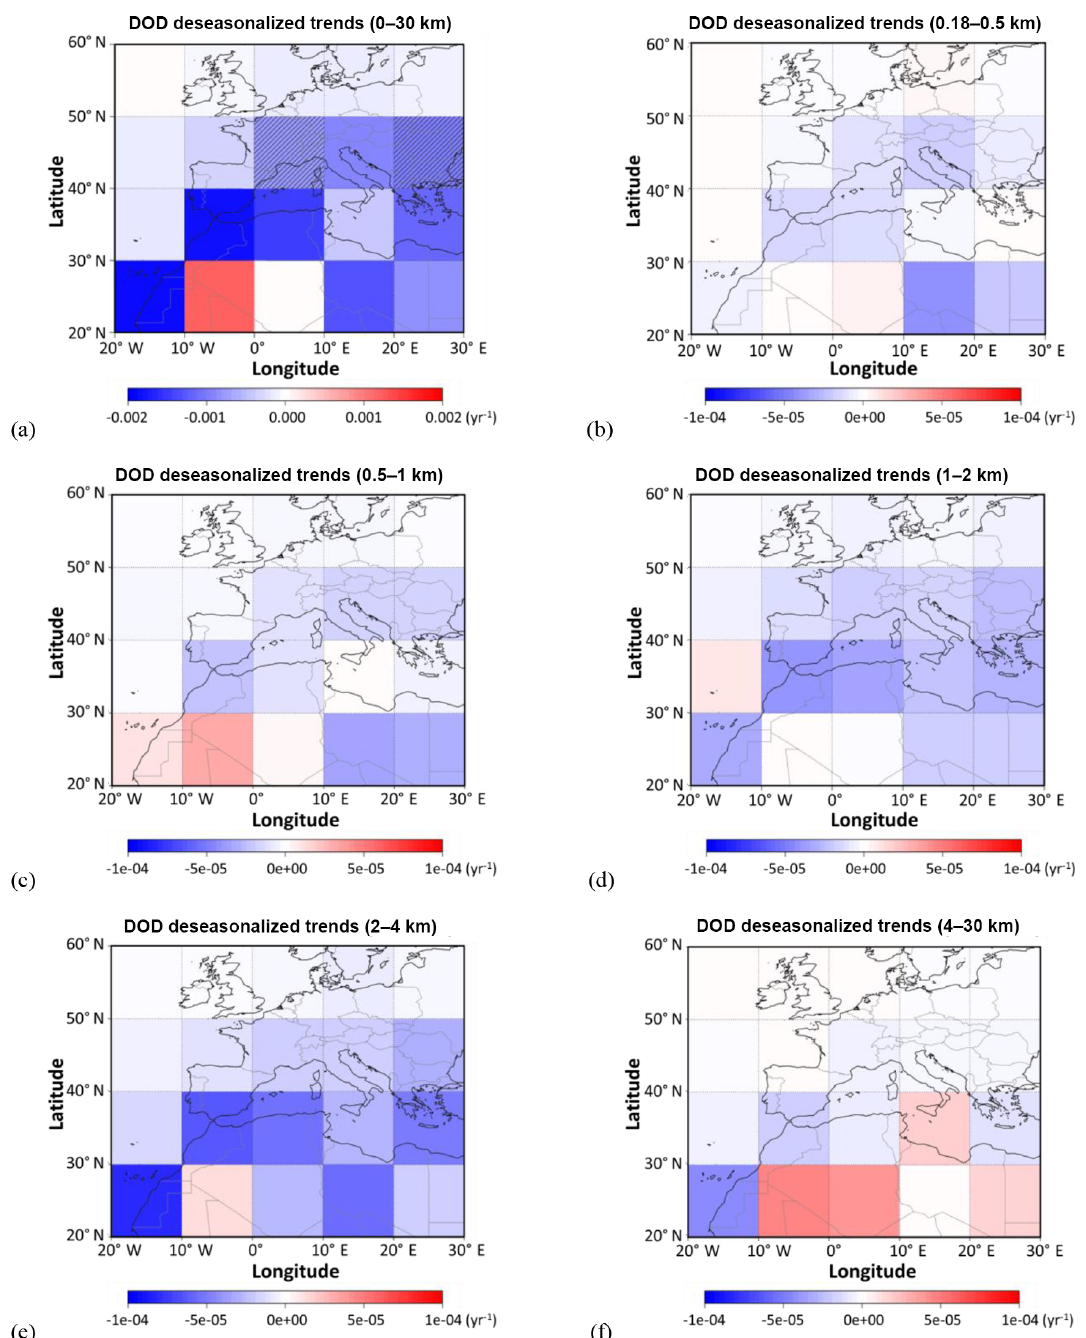
Figure 7. Geographical distribution of the deseasonalized trends (yr − 1 ) derived from monthly columnar DOD (a) and for five individual layers (b–f) , for the period 2007–2015, aggregated over 10 ◦ × 10 ◦ grid cells. Hatched filled grid cells depict the statistical significance trends with 99%